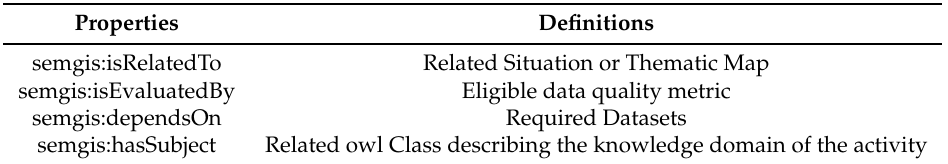
Table 3. Vocabulary Definitions for activities: Activities need to be related to situations and depend on certain datasets for evaluation